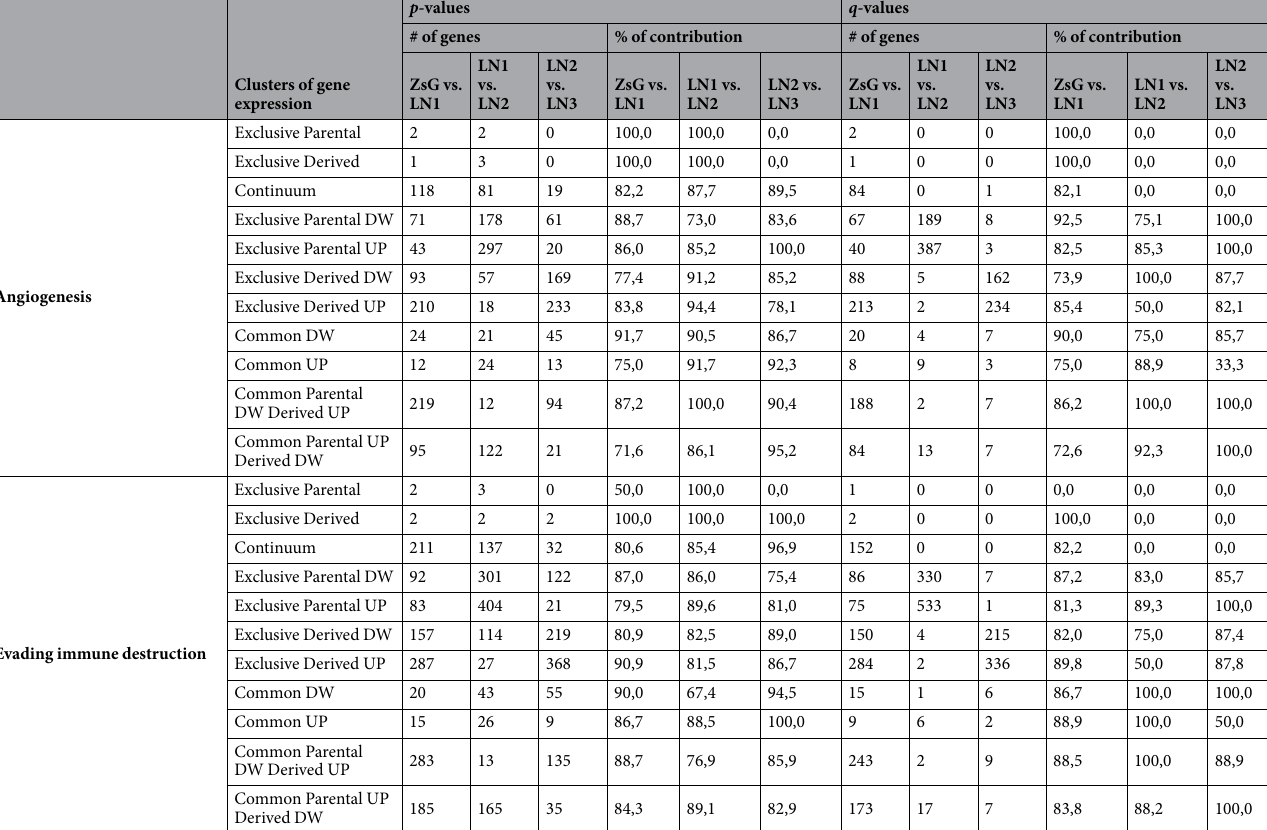
Table 2. Number of differentially expressed genes (DEGs) for each comparison between the transformed cell lines in 11-clusters of gene expression into the 8 + 2 hallmarks of cancer (panels 1 and 3) and percentages of the genetic contribution of each hallmark of cancer to the invasion and metastasis process (panels 2 and 4). DW: down regulated; UP: up regulated, for Clusters of Gene